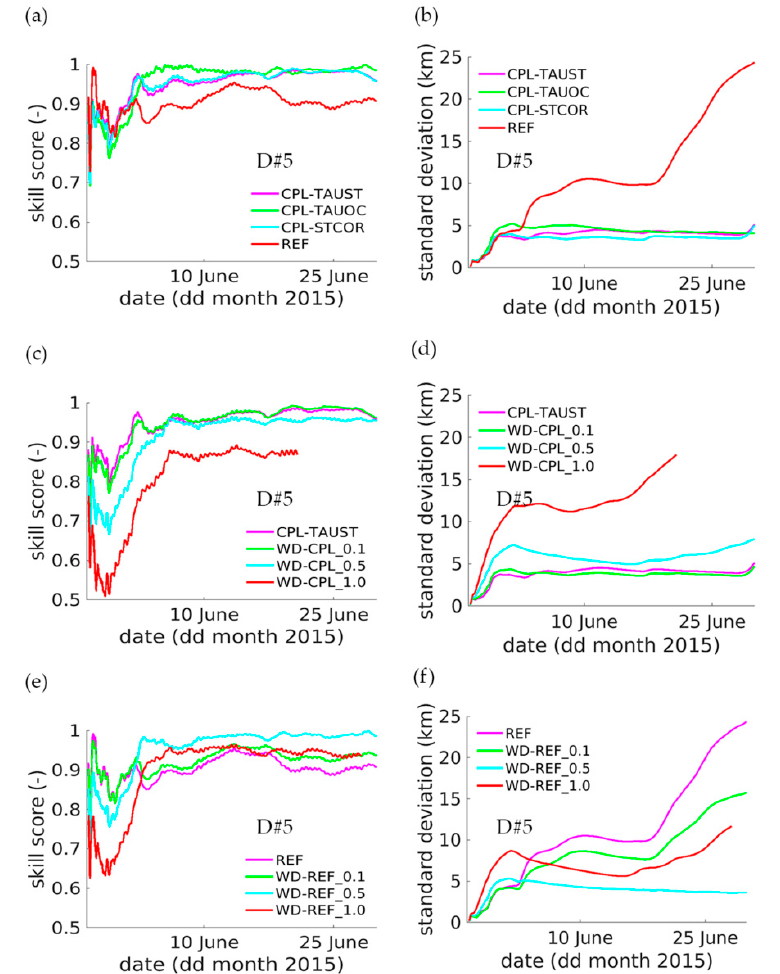
Figure 9. Time series of the skill score and the standard deviation of the distance (km) between the observed and model drifter trajectories of the different experiments (see the Table 1 and the legend): (CPL ( a , b ), WD-CPL ( c , d ) and WD-REF ( e , f ).